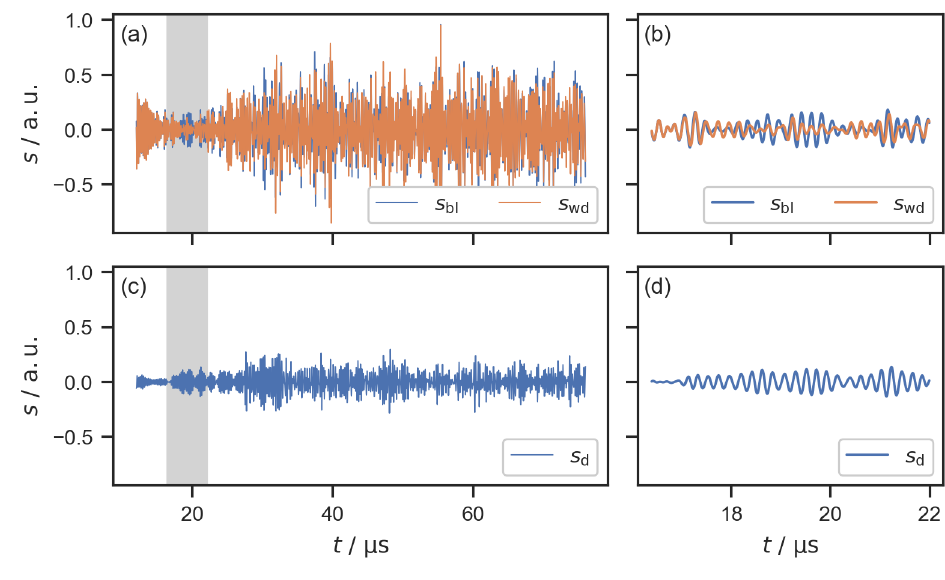
Figure 4. ( a ) Filtered signals transmitted from PWAS 1 and received at PWAS 2. The baseline signal s bl was recorded without a water drop on the flow field and the measurement signal s wd was recorded with a single water drop on the flow field. ( c ) Difference signal s d . ( b , d ) Detailed views of the highlighted signal